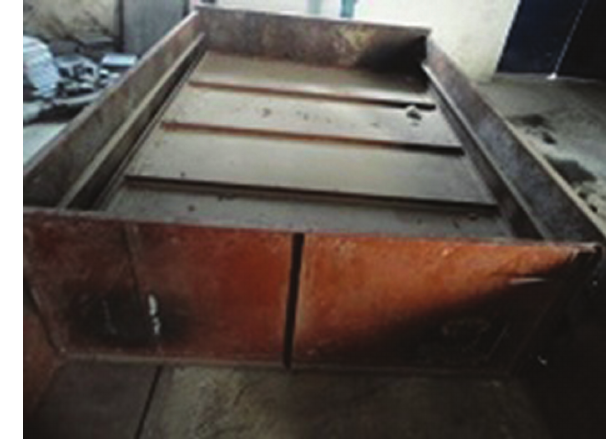
Figure 8 Heat-curing chamber under operation